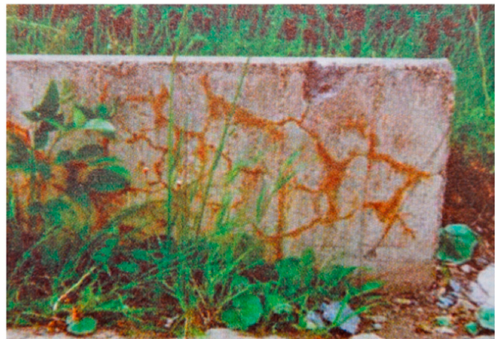
Figure 11. Map cracking due to alkali silica reaction, ASR deterioration on a concrete wall